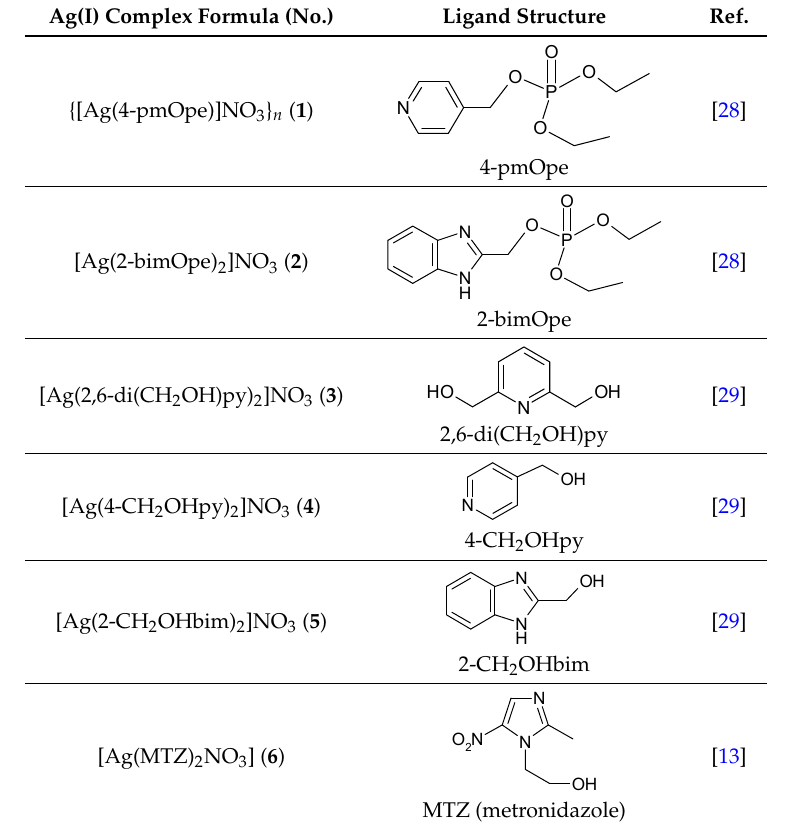
Table 1. Empirical formulae of silver(I) complexes and structural formulae of ligands. Ag(I) Complex Formula (No.)